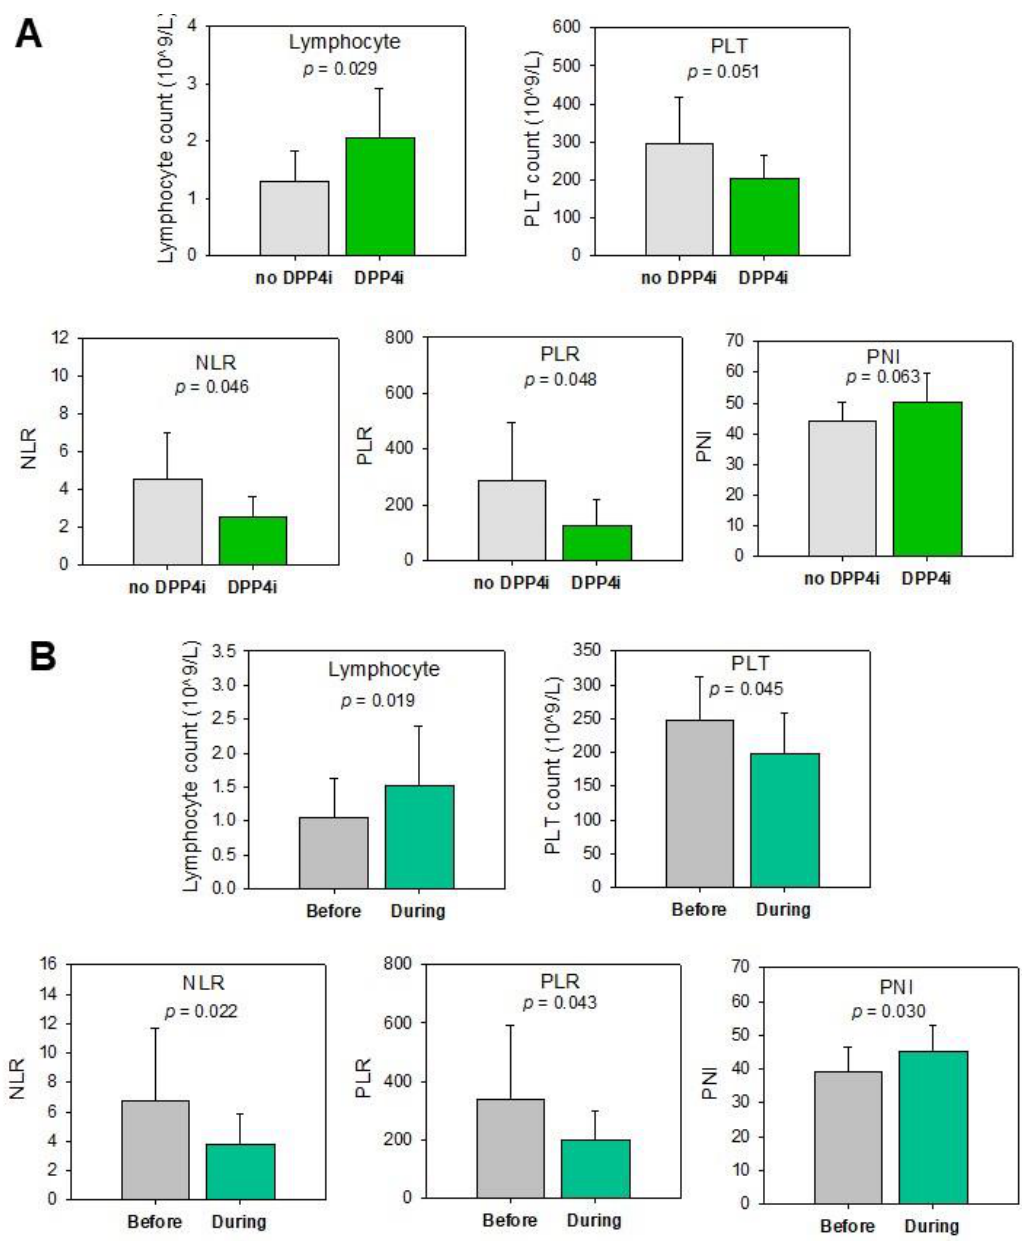
Figure 3. DPP4-inhibitors alter the immune cell profile of CRC patients. ( A ) The DPP4-inhibitor group showed a higher lymphocyte count, PNI and a lower PLT count, NLR and PLR in post-operative chemotherapy treated patients. ( B ) Change in the immune cell profile before and after DPP4-inhibitor treatment in post-operative patients. DPP4i: DPP4-inhibitors; Before: before DPP4-I treatment; During: administrated DPP4-inhibitors for 1–3 months (except over 3 months for PLT). PLT, platelet; NLR, neutrophil-to-lymphocyte ratio; PLR, platelet-to-lymphocyte ratio; PNI, prognostic nutritional index.